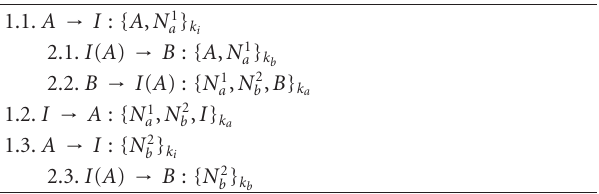
Table 11: Flaw in the NSL-protocol under the homomorphic